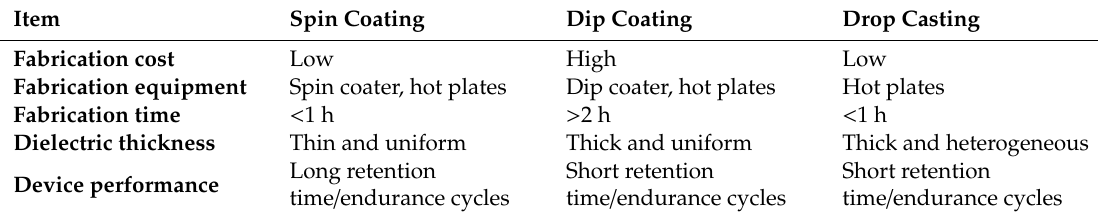
Table 2. Comparison among main solution-processed technologies [73–78]. Item Spin Coating Dip Coating Drop Casting Fabrication cost Low High Low Fabrication equipment Spin coater, hot plates Dip coater, hot plates Hot plates Fabrication time Thin and uniform Thick and uniform Device performance